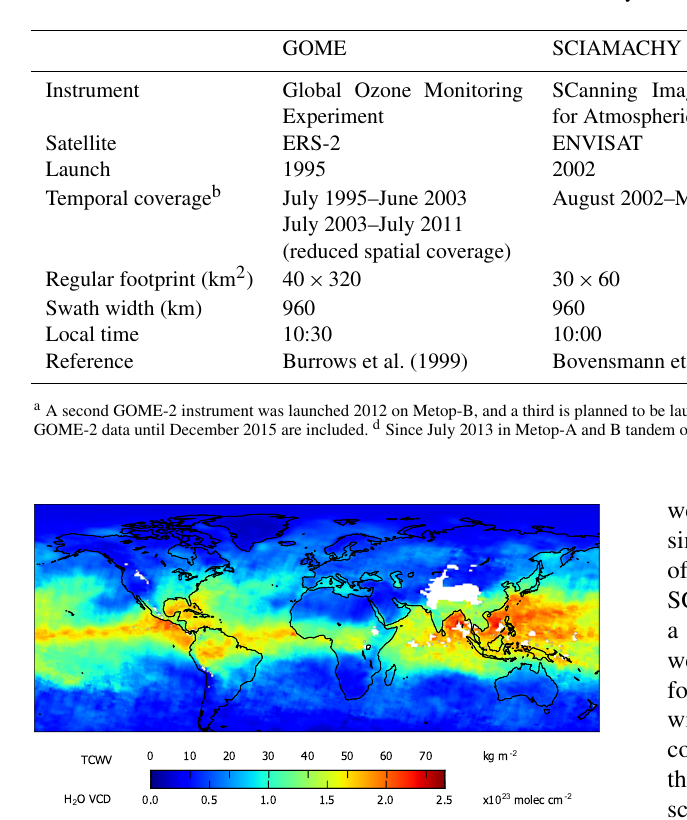
Table 1. Characteristics of the satellite instruments used in this study.